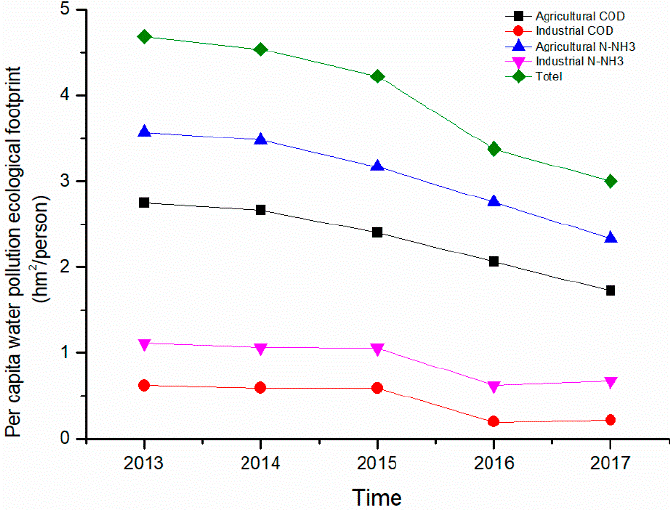
Figure 4. The per capita water pollution ecological footprint (PCWPEF) of the lower reaches of the Yellow River in 2013–2017.